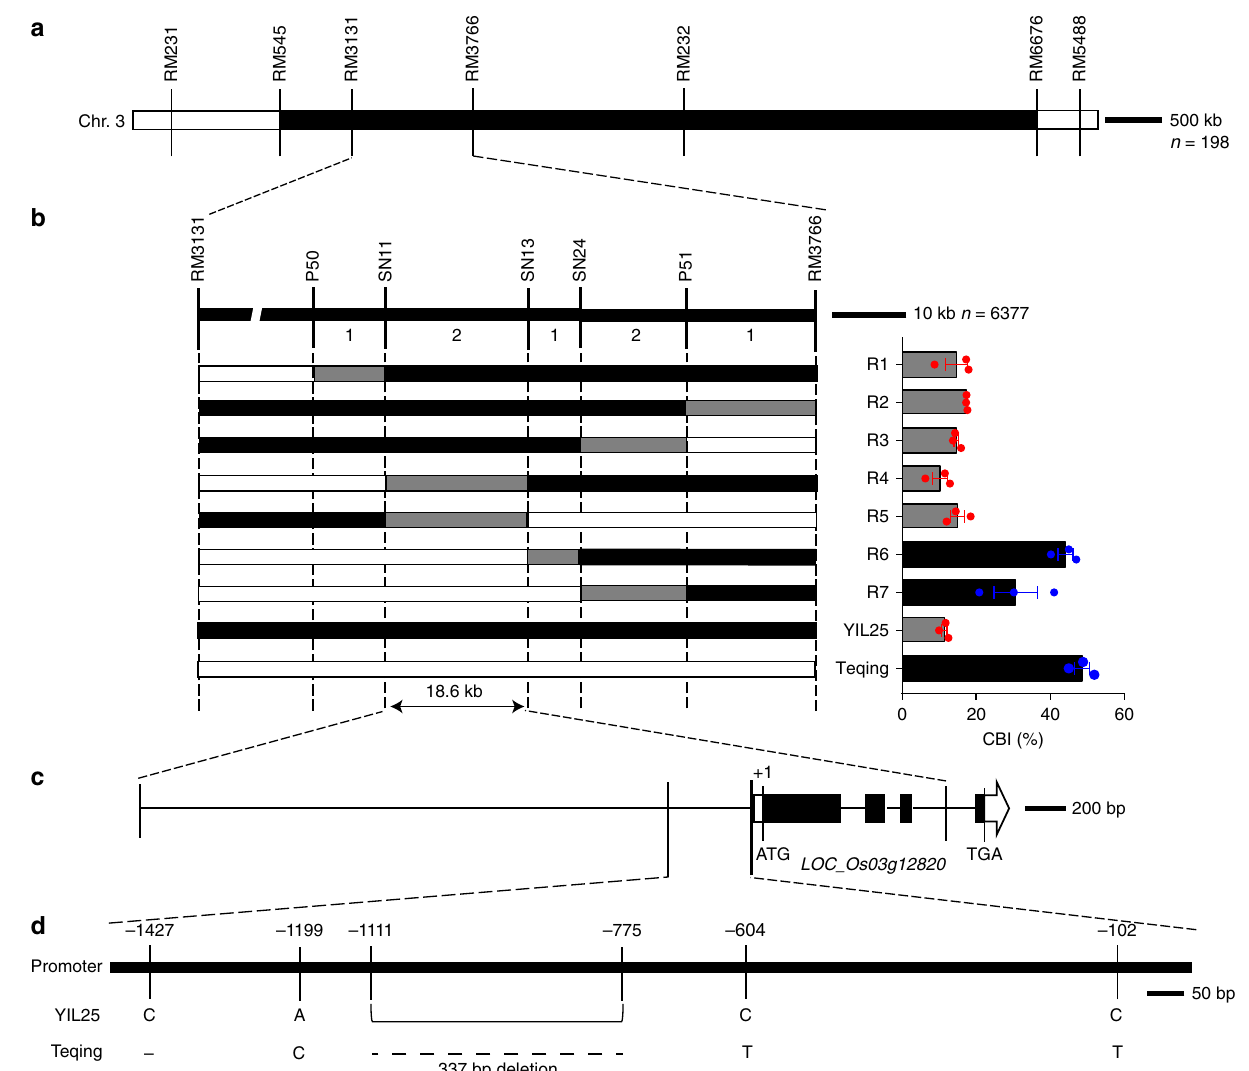
Fig. 2 Map-based cloning of the callus browning trait gene. a qCBT3 was initially localized to a region between markers RM3131 and RM3766 on the short arm of chromosome 3 ( n = 198 plants of F 2 populations derived from a cross between YIL25 and Teqing). Scale bar, 500 kb. b Positional cloning narrowed the qCBT3 locus to an 18.6 kb region between markers SN11 and SN13 ( n = 6377 individuals used for high-resolution mapping). R1 through R7 are recombinants. The black, white, and gray regions indicate homozygous for the YIL25 genome, homozygous for the Teqing genome, and the interval in the chromosome where crossover took place, respectively. Scale bar, 10 kb. LOC_Os03g12820 is the candidate gene BROWNING OF CALLUS1 ( BOC1 ). Data are means ( n = 3 biologically independent samples), with error bars showing standard error. c Structure of the candidate gene BOC1 . White box, white box with arrow, black boxes, and lines between boxes indicate the 5 ′ -UTR, 3 ′ -UTR, exons, and introns, respectively. d Mutation sites of the BOC1 promoter in YIL25 and Teqing. The ellipsis indicates deletion of bases. Scale bar, 50 bp. Source data underlying Figs. a , b are provided as a Source Data fi